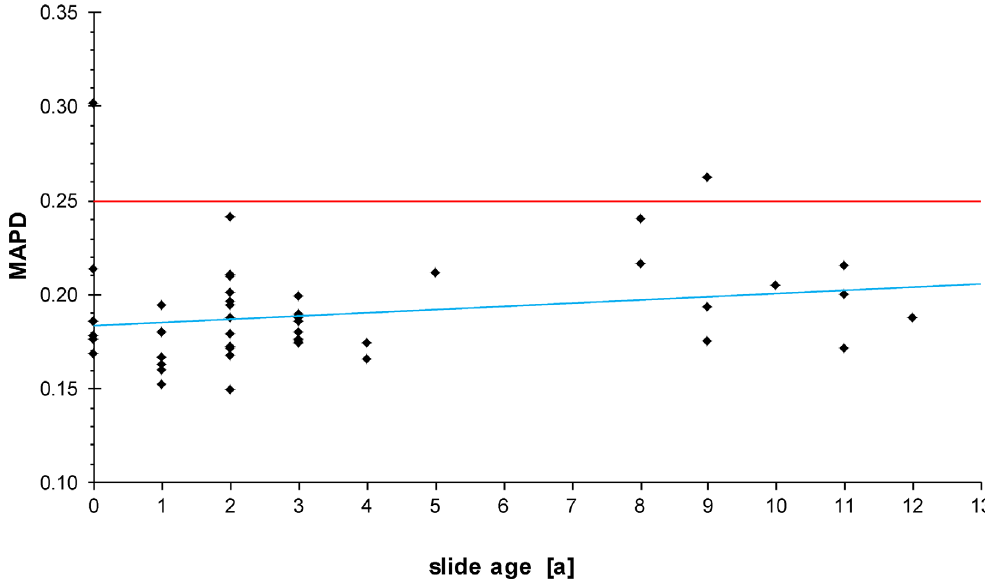
Fig 1. Influence of slide age on array data quality (MAPD values). The linear trend line is shown in blue. MAPD values below 0.25 (red line) are considered to represent a good quality.